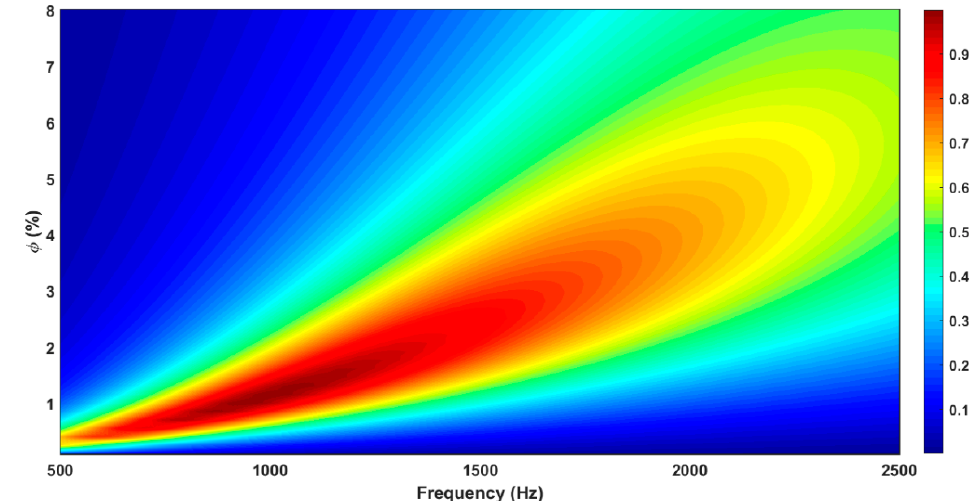
Buildings 2019 , 9 , x FOR PEER REVIEW Figure 8. Absorption coefficient of an SL-MPP as a function of ( f , φ ) for ( d , t , D ) = (0.4 mm,1 mm,2 cm). Figure 8. Absorption coefficient of an SL-MPP as a function of ( f ,  ) for ( d , t , D ) = (0.4 mm,1 mm,2 cm).